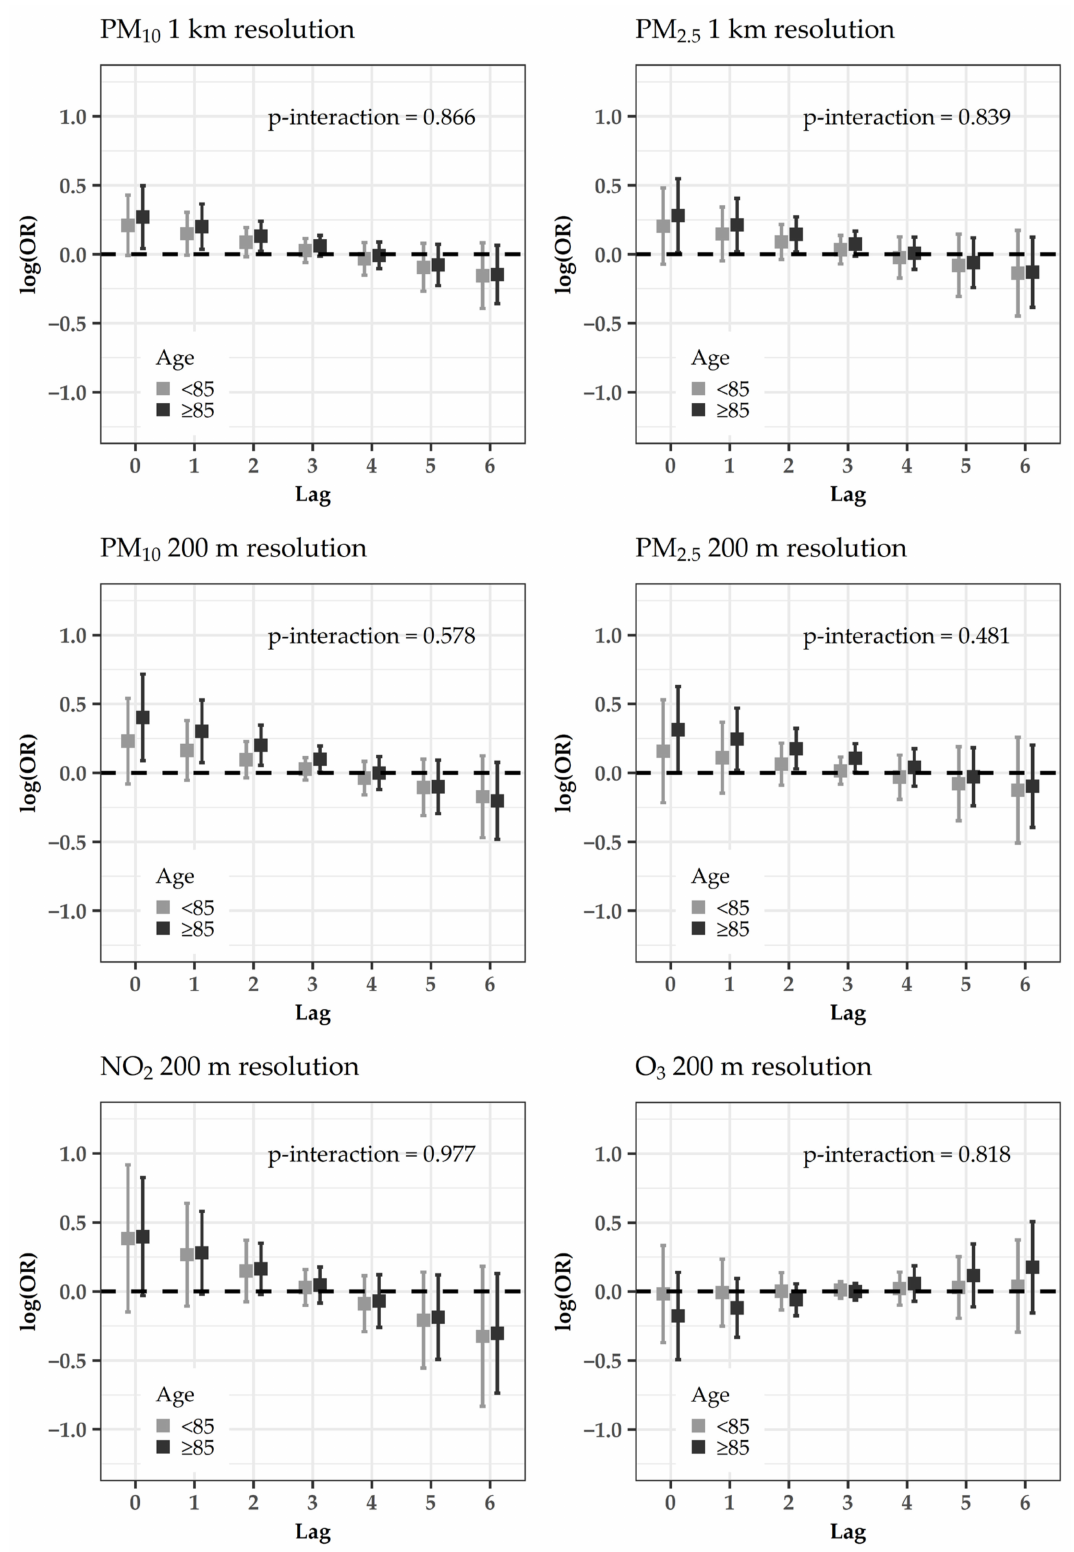
Figure 4. Acute effects of estimated pollution levels (sub-period 2013–2015) on the risk of cardiovascular hospitalizations: log-odds ratios (OR) and 95% confidence intervals for the conditional logistic regression models with distributed lags, stratified by age group. p -values for interactions are